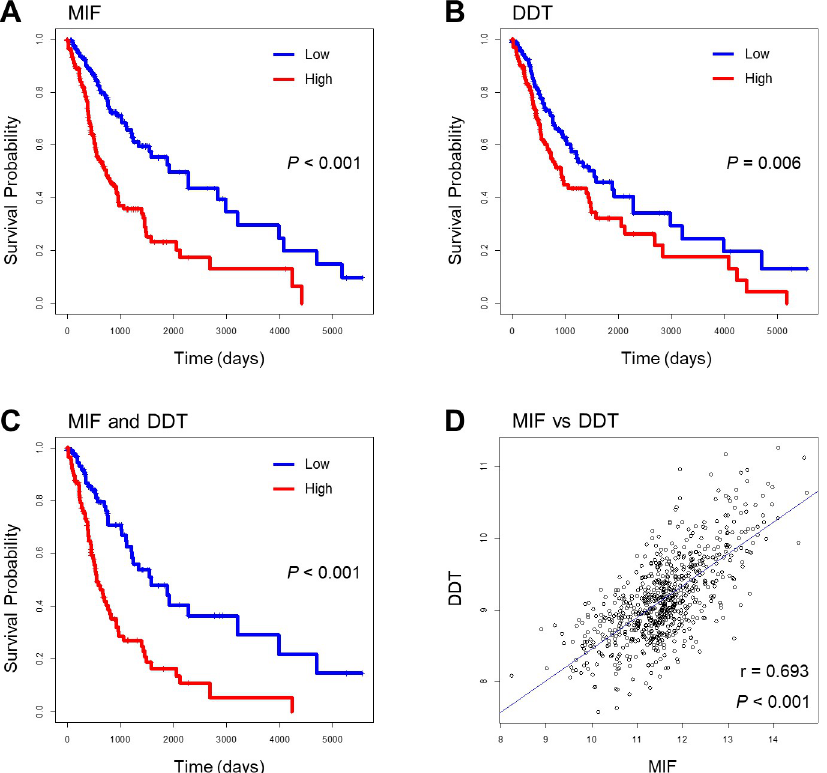
Fig 1. Kaplan-Meier survival curve and Pearson correlation coefficient based on the categorization of MIF and DDT expressions in the UCSC Xena platform.